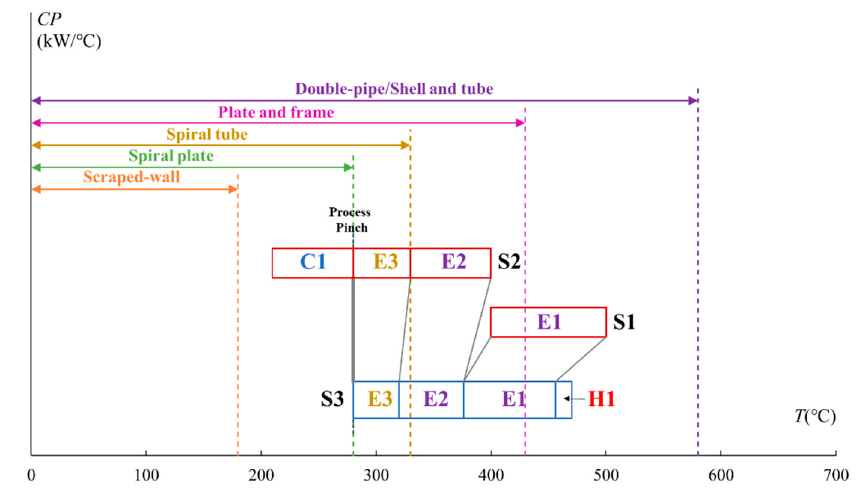
Figure 4. SRTGD-STR of the second retrofit plan for Example 1.